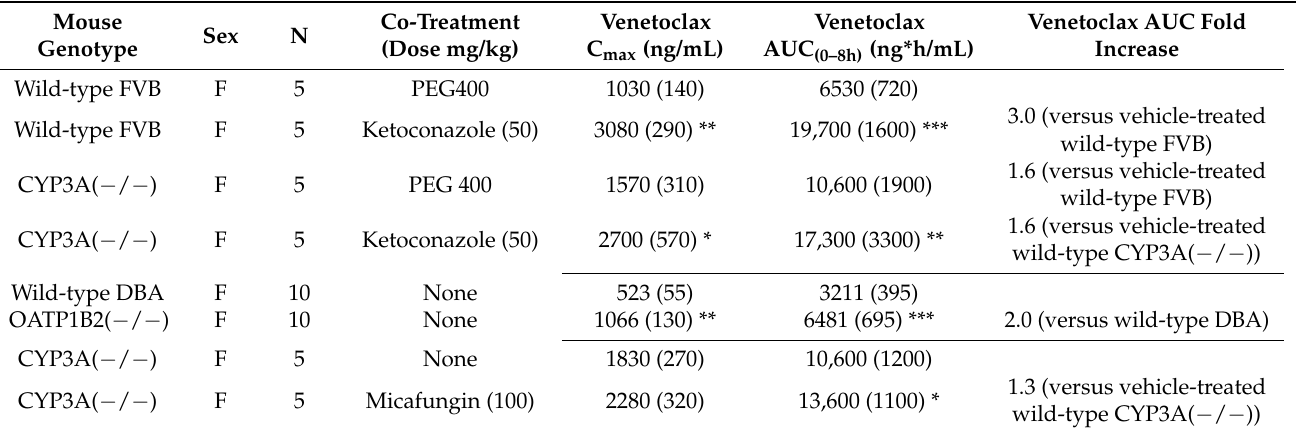
Table 1. Venetoclax pharmacokinetic